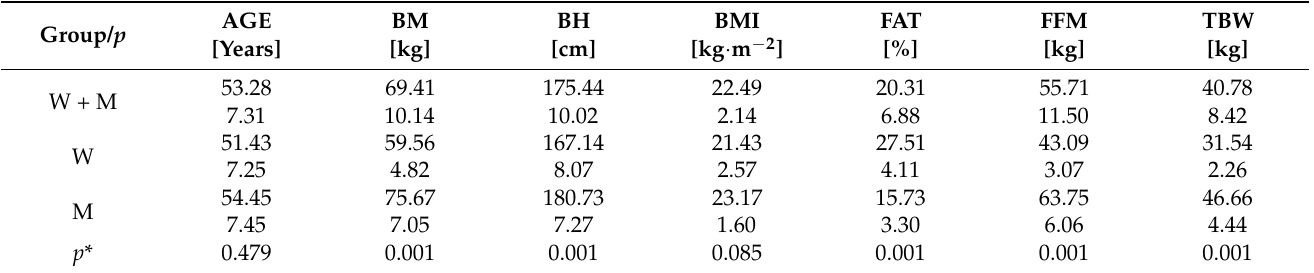
Table 1. Somatic characteristics (mean ± SD) of the whole group of subjects (W + M; n = 18), group of women (W; n = 7), group of men (M; n = 11).